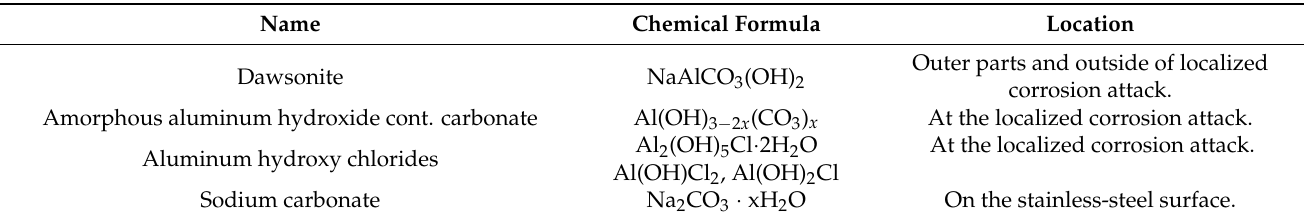
Table 6. Corrosion products formed during the galvanic corrosion experiments from FT-IR microscopy.